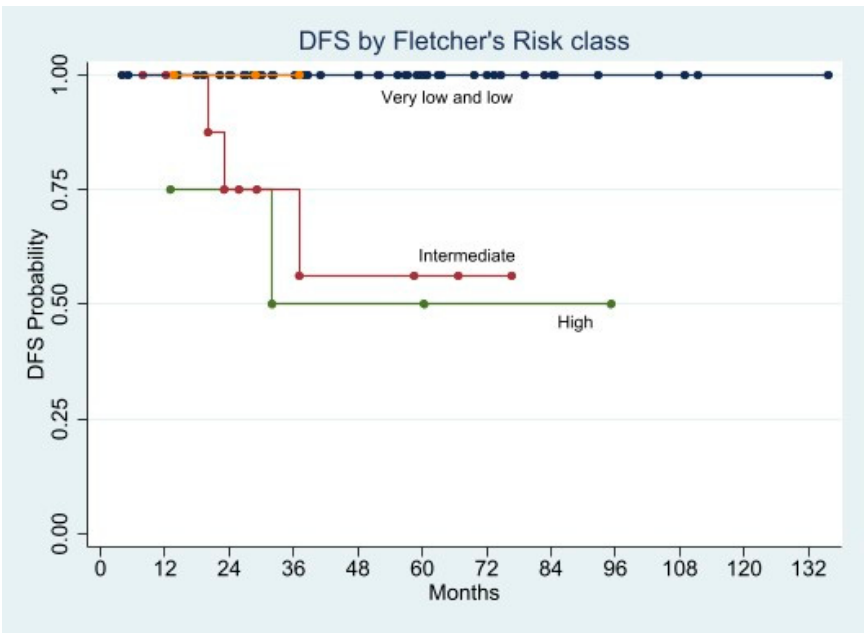
Figure 9. Disease Free Survival by Fletcher’s Risk class.